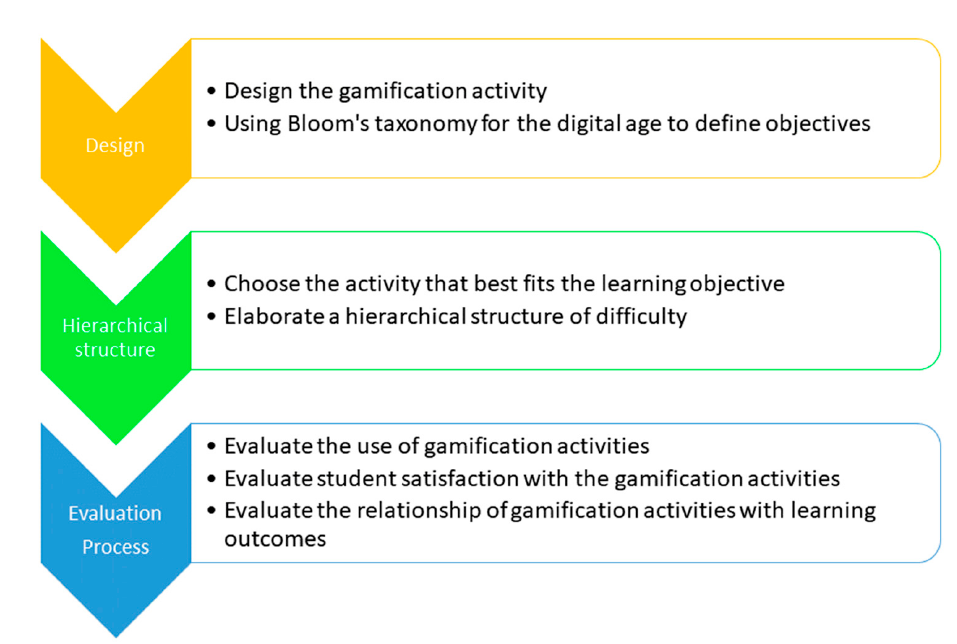
Figure 1. Process for the design and evaluation of gamification activities.